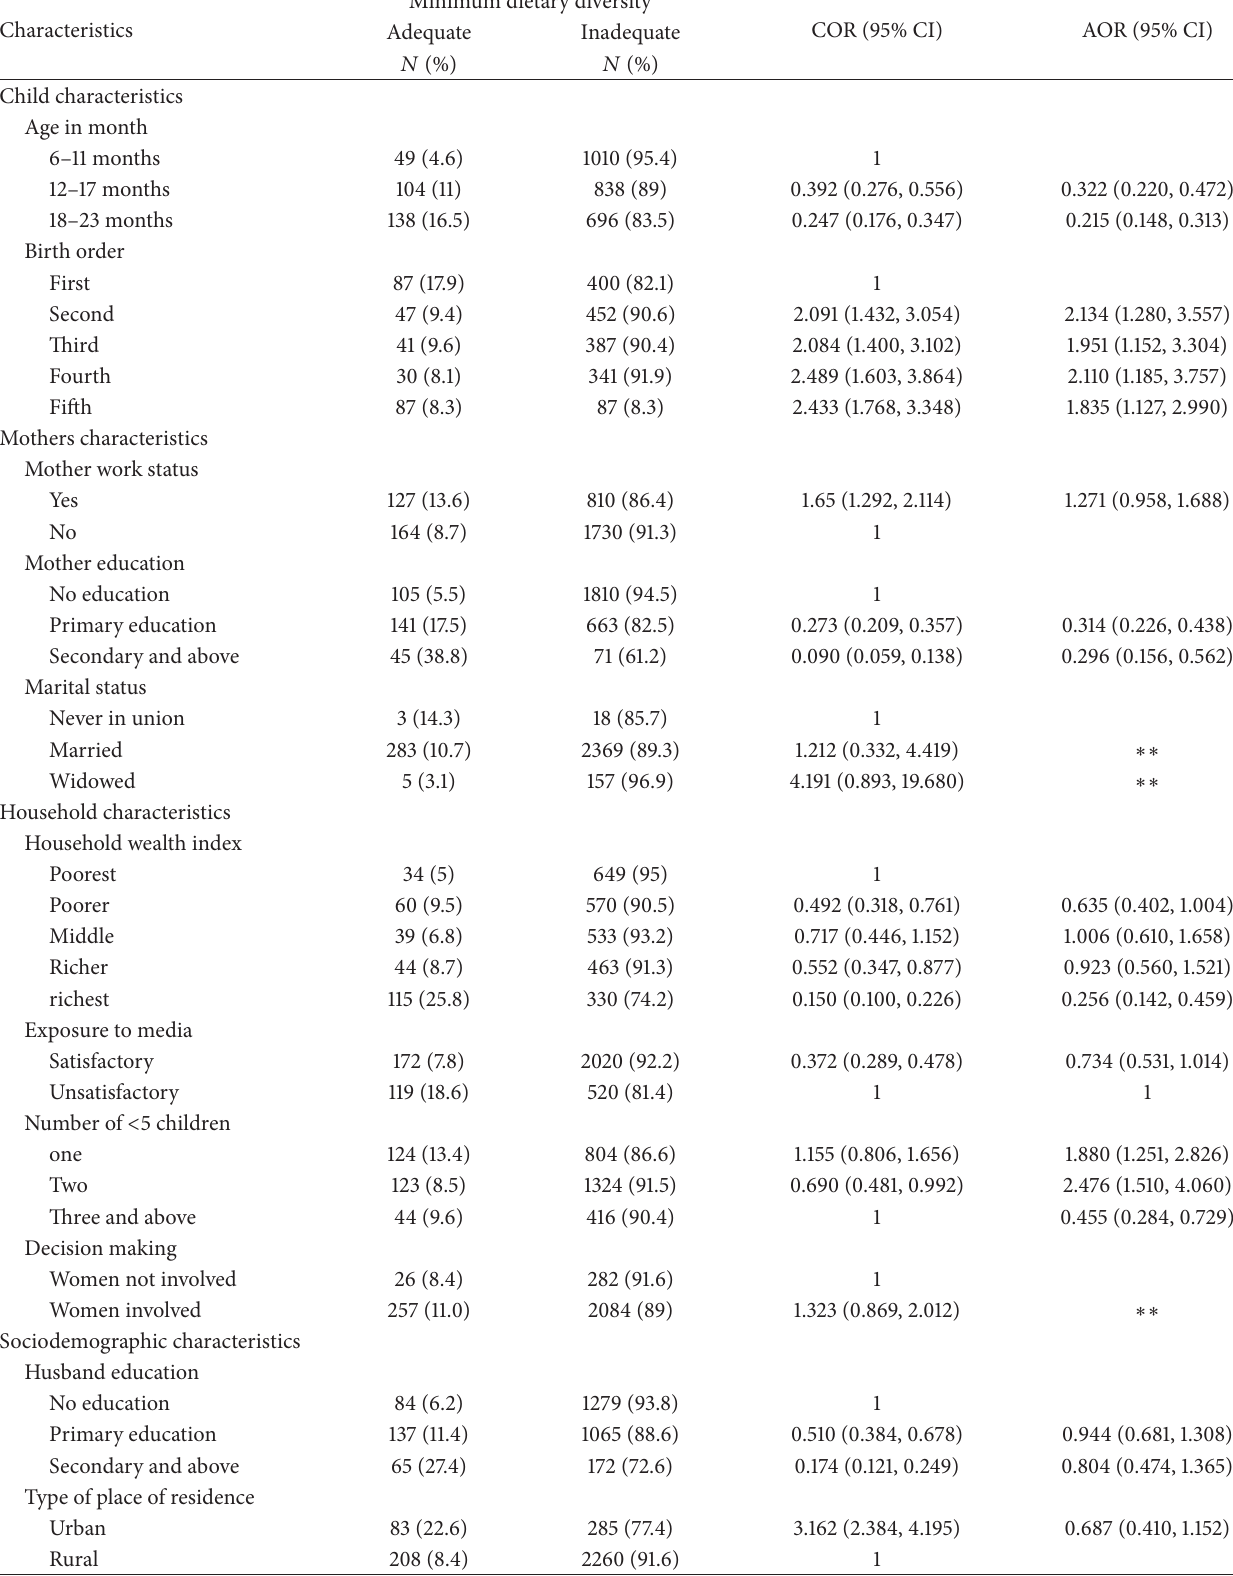
Table 2: Factors associated with minimum dietary diversity practice, Ethiopia,